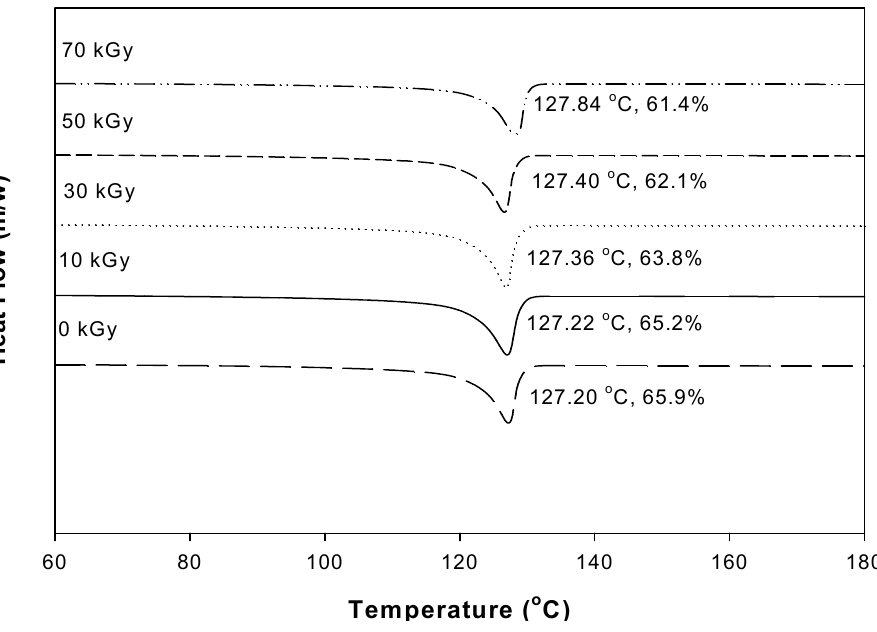
Figure 6. Differential scanning calorimetry (DSC) micrographs of PU (1 phr)/HDPE composites at various absorption doses.